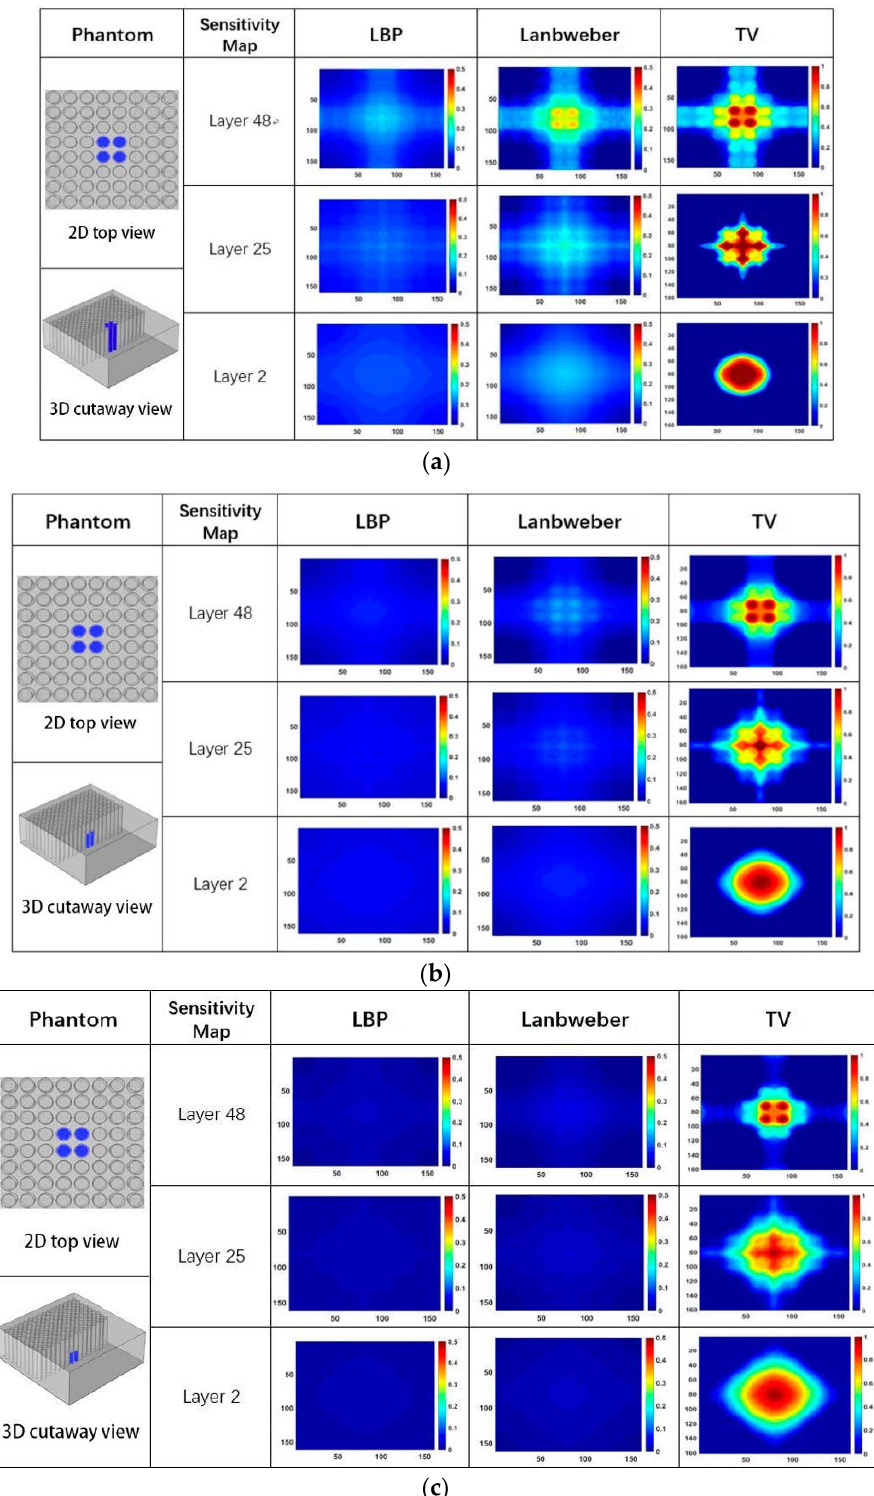
Figure 9. The imaging results while the central four column holes are full of different quantities of water, ( a ) 100% full of water, ( b ) 50% full of water, ( c ) 25% full of water.